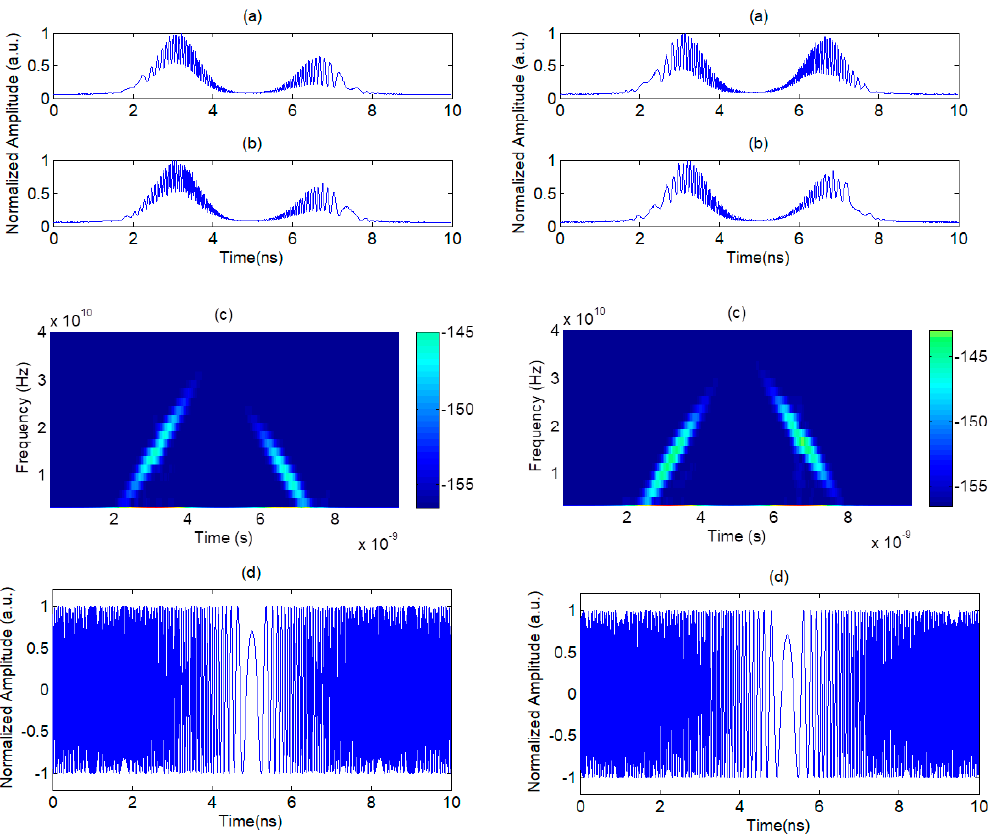
Figure 13. Measured chirped microwave waveforms when applying a temperature of ( a ) 30 °C and ( b ) 50 °C to Sensor 1, while keeping Sensor 2 at constant temperature; ( c ) Calculated spectrogram for the waveform in (a); ( d ) Reference signal used to compress the waveforms in (a,b). Measured chirped microwave waveforms when applying a temperature of (a) 21 °C and (b) 50 °C to Sensor 2 while keeping Sensor 1 at constant temperature; (c) Calculated spectrogram for the waveform in (a); (d) Reference signal used to compress the waveforms in (a,b) (after Reference [13]).